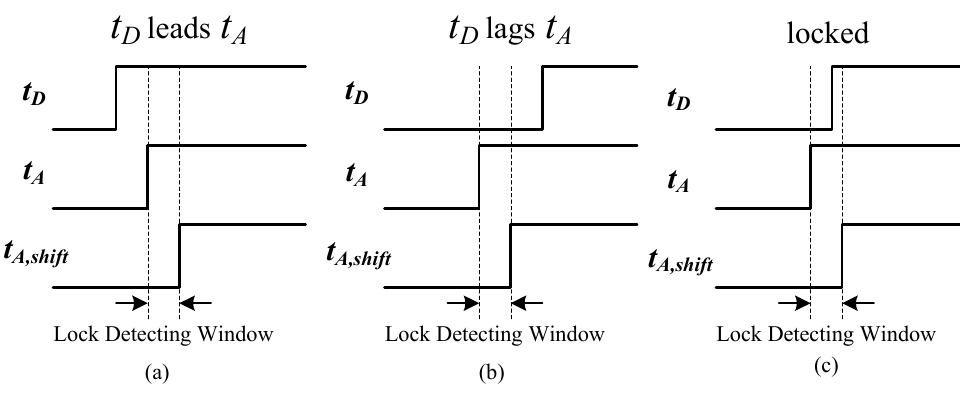
Figure 11. Operation principle with three differing